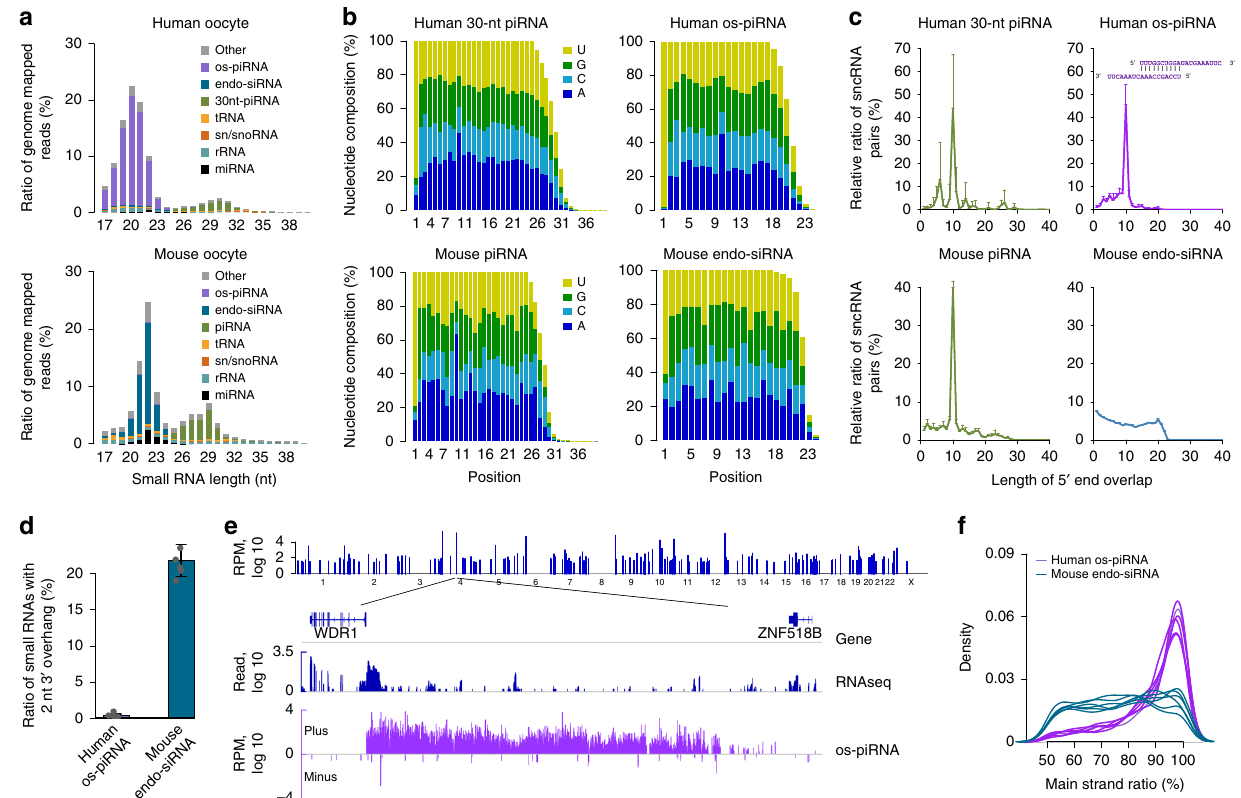
Fig. 2 Characteristics of novel 20-nucleotide (nt) small RNAs (oocyte short-PIWI-interacting RNAs (os-piRNAs)) in human oocytes. a Composition of small RNA categories according to their length distributions in both human and mouse oocytes. The length of os-piRNAs in human oocytes was ~2 nt shorter than that of mouse endo-small interfering RNAs (endo-siRNAs). b The relative nucleotide composition of piRNAs, endo-siRNAs, and os-piRNAs in a . Both os-piRNAs and the 30-nt piRNAs in human oocytes, as well as the piRNAs in mouse oocytes, have a preference of 1U and 10A in nucleotide compositions. c Length distribution of 5 ′ overlaps between small RNA pairs mapped to the opposite genomic strands of the same locus. The spike at 10 nt indicates the signature of a 10-nt 5 ′ -end overlap between the partially complementary small RNA pairs. An example of an os-piRNA pair with a 10-nt 5 ′ - end overlap signature is shown. d The proportion of complementary reads with a 2-nt 3 ′ overhang in human os-piRNAs was signi fi cantly lower than that in mouse endo-siRNAs. The average result in six human/mouse oocyte samples is shown in a – d , and the error bars in c , d represent the standard deviation. e Distribution of os-piRNA clusters on human chromosomes (top) and an instance of an os-piRNA cluster (bottom). The positive and negative numbers of the vertical axis represent the expression on the plus and minus strands, respectively. f Human os-piRNAs were more prone to be derived from single- stranded precursors compared to mouse endo-siRNAs. Strand bias in six replicate samples is shown. Source data of a – f are provided in the Source Data fi